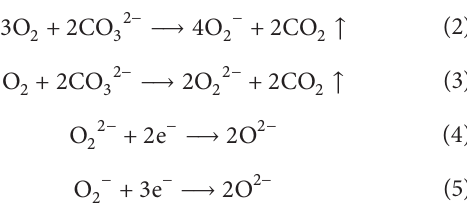
reduced to oxygen ion by the electrons provided by the anode reaction as in reaction (4) or (5) [21,